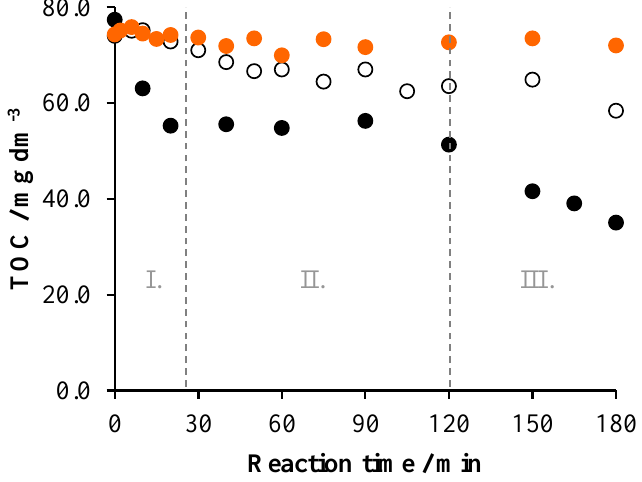
Figure 1. The change of the TOC as a function of time under various conditions in the system containing 2 × 10 −4 mol·dm −3 Triton X-100 and 1 g·dm −3 TiO 2 : air (•), air/UV (○) and air/UV/TiO 2